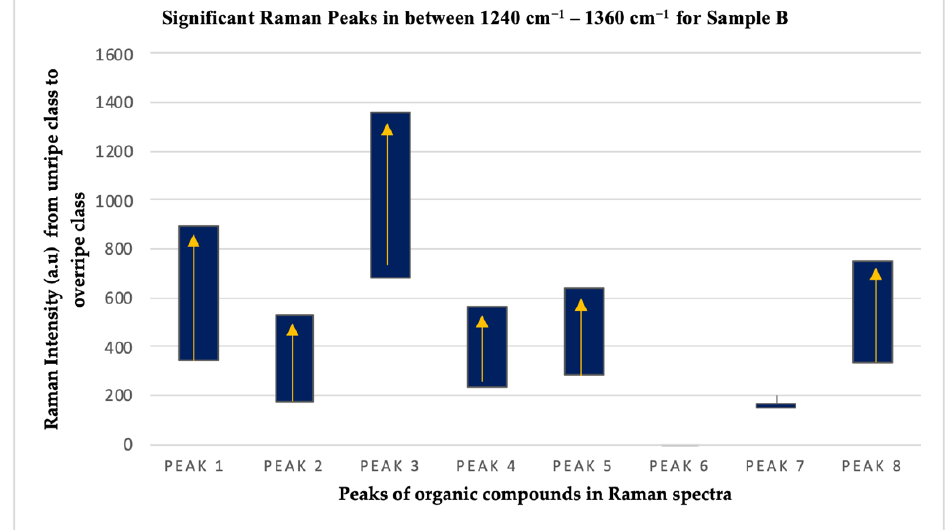
Figure 8. Trend of Raman peak intensity for the three ripeness classes in sample B.